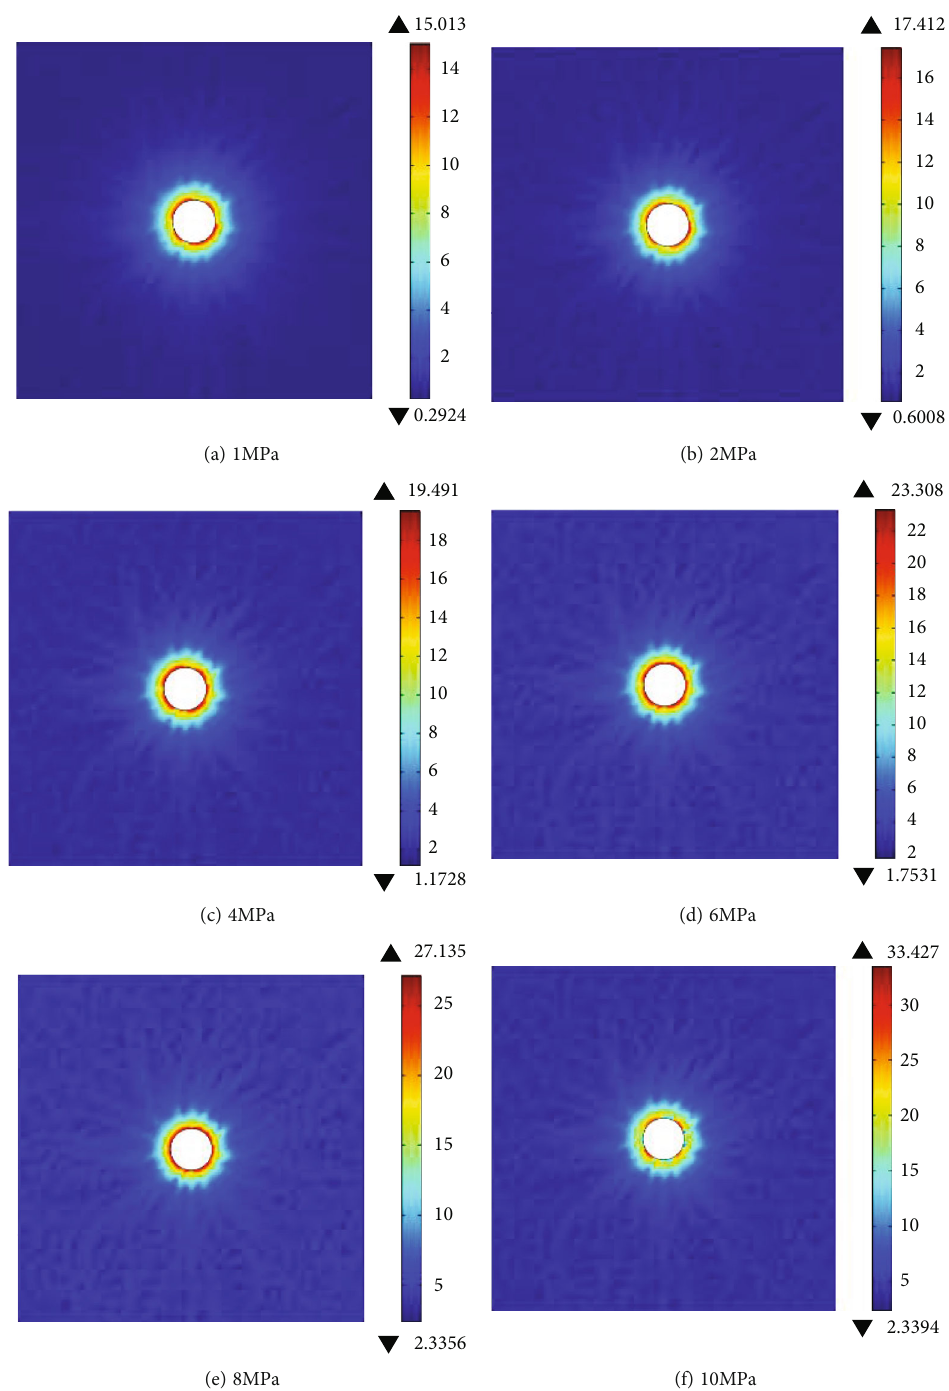
Figure 8: The Mises stress distribution under equal con fi ning